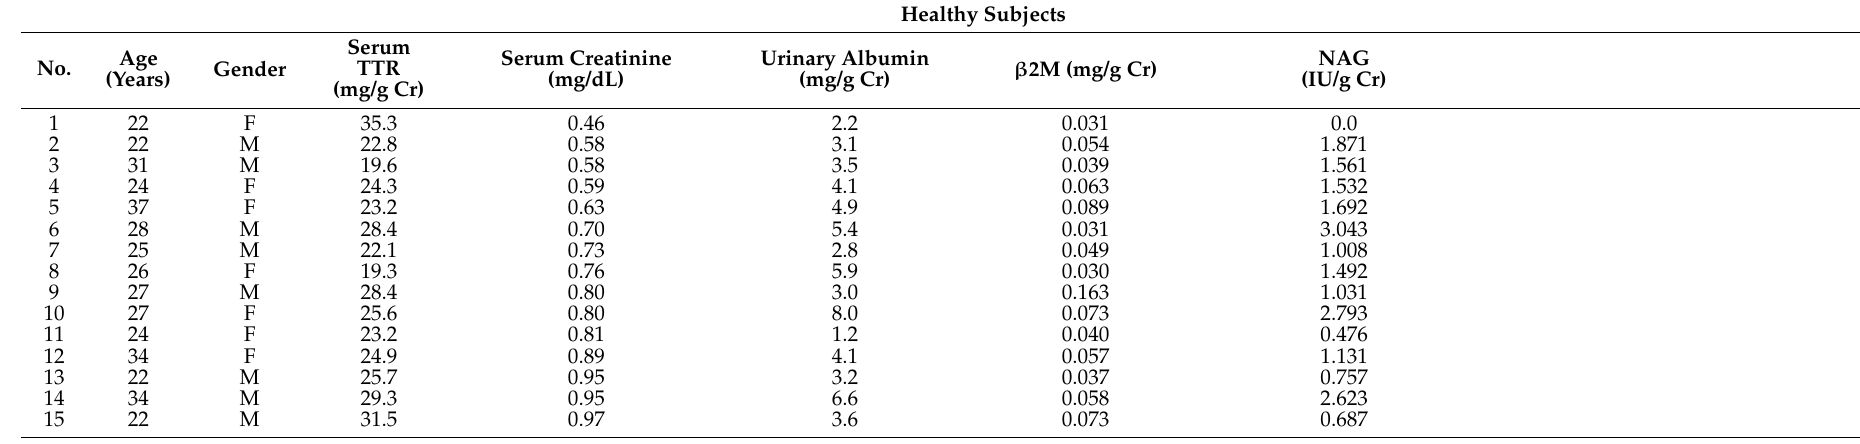
Table 1. Clinical information in healthy volunteers and ATTRv V50M